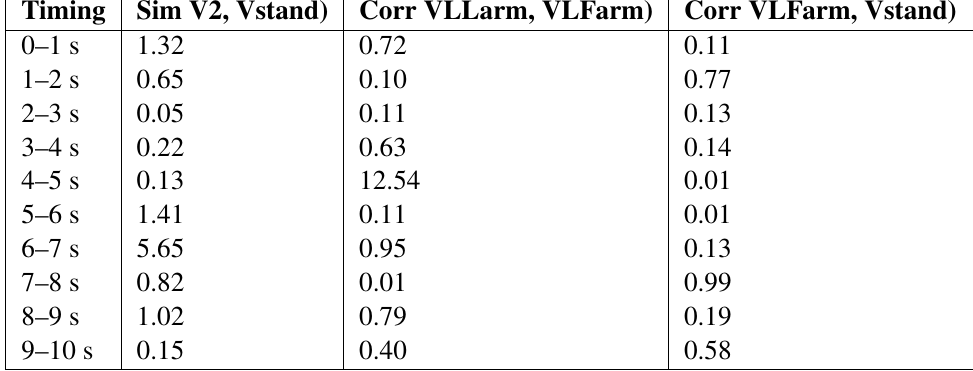
Table 5 Relative error of main movement attitude of test